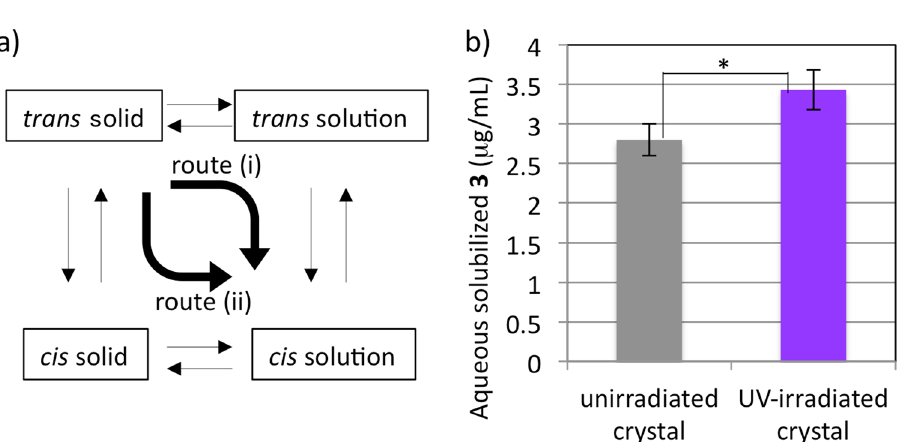
Figure 3. ( a ) Possible equilibria and routes for generating cis - 3 in solution. ( b ) Kinetics of aqueous dissolution of UV-irradiated crystals of 3 , measured in the dark. Crystals of 3 were irradiated with 365 nm LED light (344 mW/cm 2 ) at 37 °C for 3 h. The UV-irradiated crystals and unirradiated crystals were each shaken with phosphate buffer in the dark at 37 °C for 1 h. Data are the mean ± SD of three individual experiments. The asterisk indicates a significant difference ( * p < 0.05) from the unirradiated crystals according to the unpaired, two-sided Student’s t